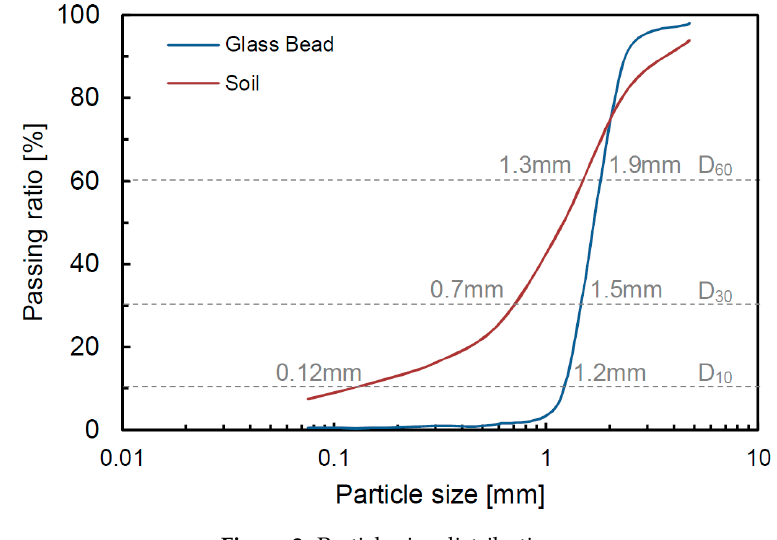
Figure 2. Particle size distributions.